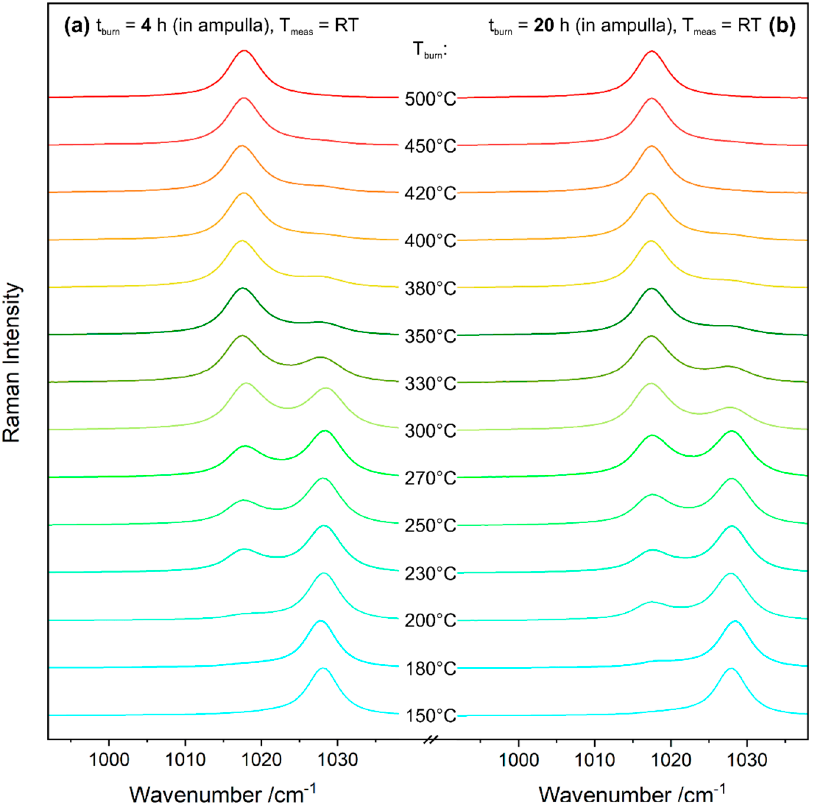
Figure 17. Raman spectra of gypsum calcination products generated in a laboratory furnace in the temperature range from 150 °C to 500 °C. The measurements were performed at room temperature.